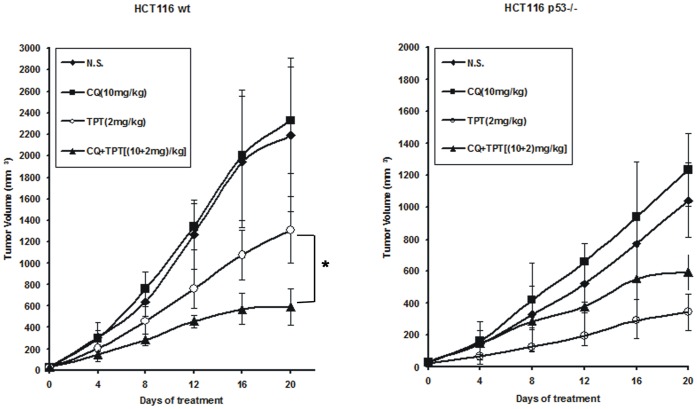
The anti-tumour activity of an autophagy inhibitor in combination with topotecan treatment in a HCT116 human colon cancer xenograft model.Athymic nude mice were injected subcutaneously with 4×106 HCT116 p53+/+ or HCT116 p53−/− cancer cells. Six mice were assigned into each of the treatment groups. The tumours were allowed to grow for approximately 5 d to produce an average tumour volume of 40 mm3 prior to drug treatment. Topotecan was intraperitoneally administered once every 4 d (2 mg/kg), and CQ was intraperitoneally administered every day (10 mg/kg). The tumour growth was measured every 4 days according to the method described in the “Materials and Methods” section. Results are presented as means ± s.d. (n  =  6). *P<0.05, Student’s t test.